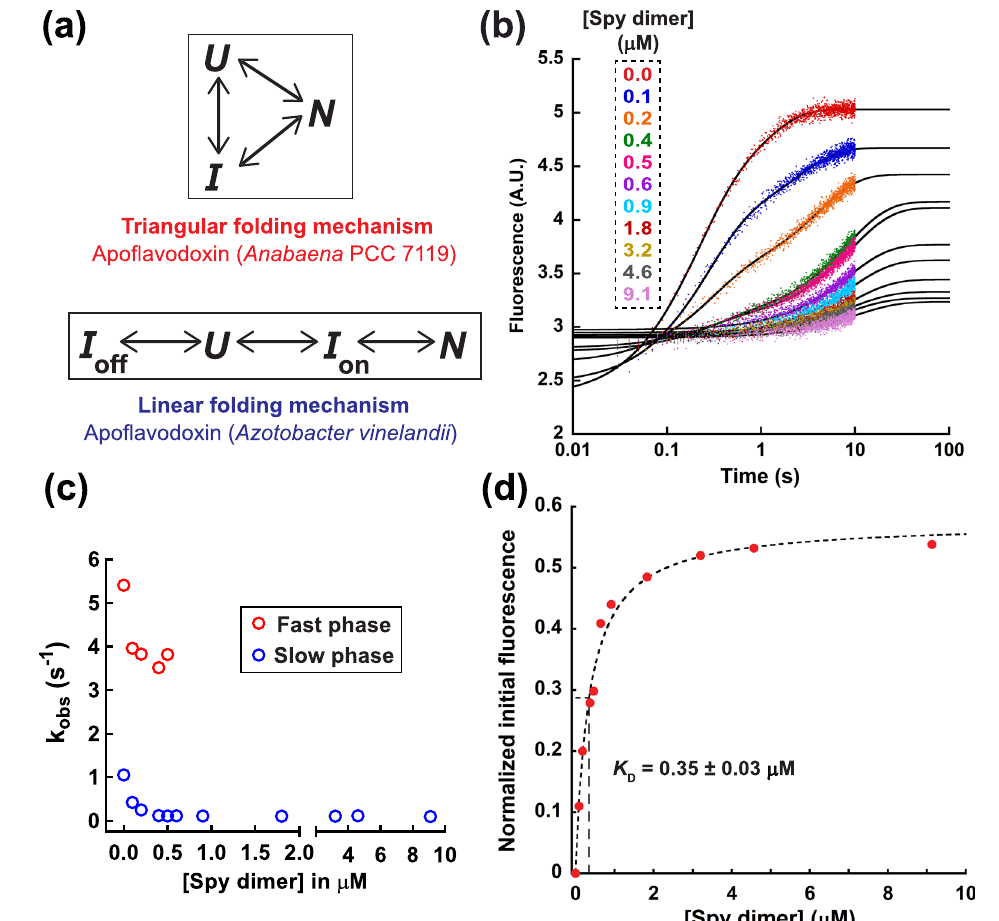
Fig. 1 Kinetics of apo fl avodoxin folding in the presence of Spy. a Folding pathway of apo fl avodoxin from Anabaena PCC 7119 (AnFld) and Azotobacter vinelandii (AzoFld) 11, 12 . N, U, and I are the native, unfolded, and intermediate states, respectively. In case of AzoFld, I pathway intermediates, respectively. b Fluorescence traces for the refolding of 0.09 µ M AnFld in the presence of various concentrations of Spy dimer (0 – 9.1 μ M after mixing). Time axis is shown in logarithmic scale. AU arbitrary units. The traces of AnFld refolding in the presence of 0 – 0.5 μ M Spy dimer could be fi t to a sum of two exponentials, and traces for higher Spy concentrations could be adequately fi t to a single exponential function. The absence of the fast phase at higher Spy concentrations most likely indicates that Spy completely blocks the direct folding pathway from unfolded to native AnFld. c Plot of the observed rate constants ( k obs ) for AnFld WT folding as a function of Spy dimer concentration. d Initial fl uorescence values were calculated from the fi t of the kinetic datasets. AU arbitrary units. The binding isotherm was plotted with normalized initial fl uorescence intensity during AnFld WT refolding in the y -axis and fi tted to a one-site binding model. All experiments were performed in HN buffer at 25 °C. Value reported is the mean ± s.e.m. of the fi